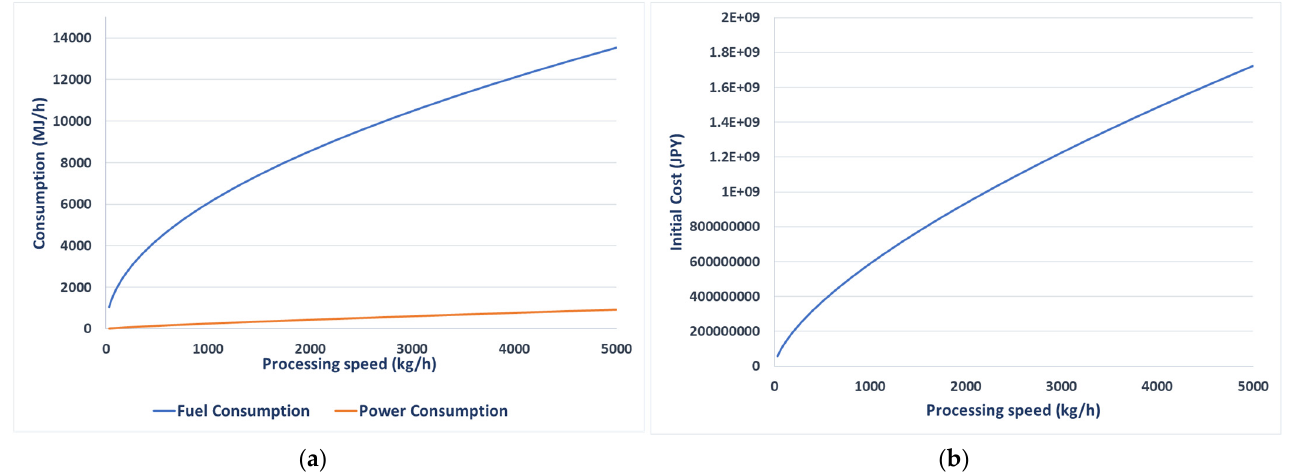
Figure 5. Schematic diagram of superheated steam gasification system.